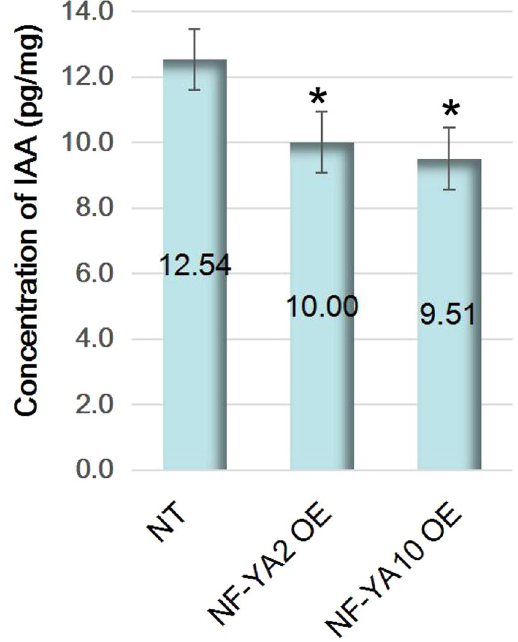
Figure 4. Concentrations of IAA in transgenic plants and NT.